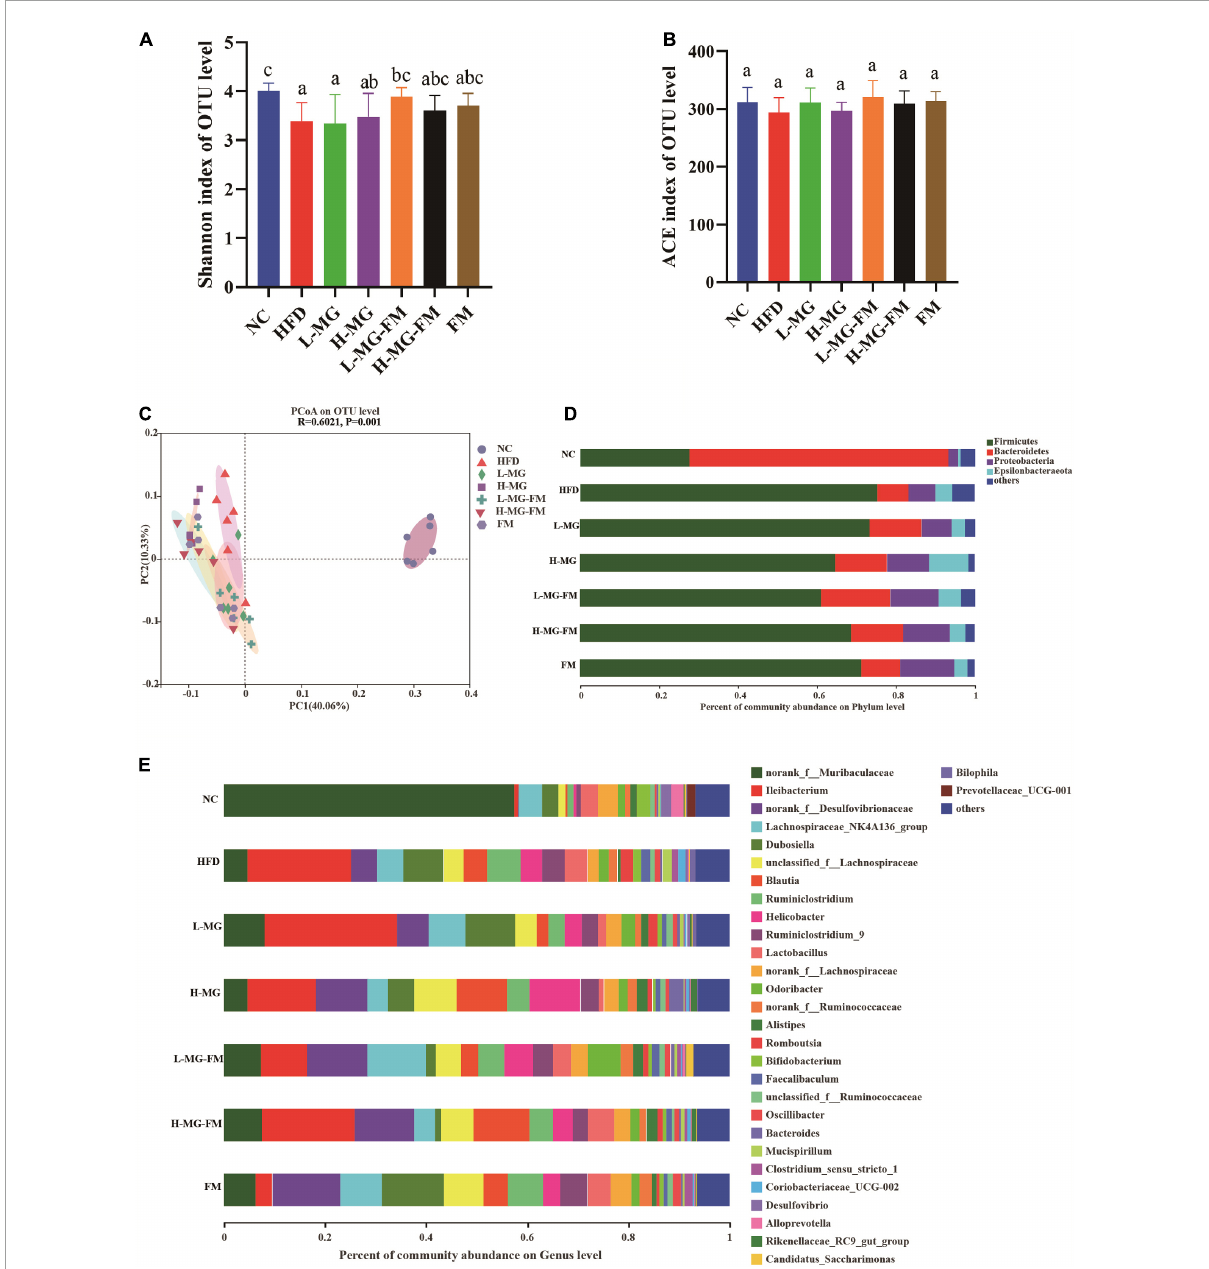
FIGURE4 Effects of MN-Gup and MN-Gup-containing fermented milk on gut microbiota under HFD ( n = 6). (A,B) The Shannon and abundance-based coverage estimators (ACE) indexes of bacterial α diversity. Different letters indicate significant differences in mice ( p < 0.05). (C) PCoA based on bacterial operational taxonomic units (OTUs) using unweighted-unifrac calculation. ANOSIM was used to analyze the similarity analysis, and R value > 0 indicates that the difference between groups is greater than the difference between groups, and p < 0.05 indicates significant differences. (D) The average relative abundance of bacteria at the phylum level. (E) The average relative abundance of bacteria at the genus